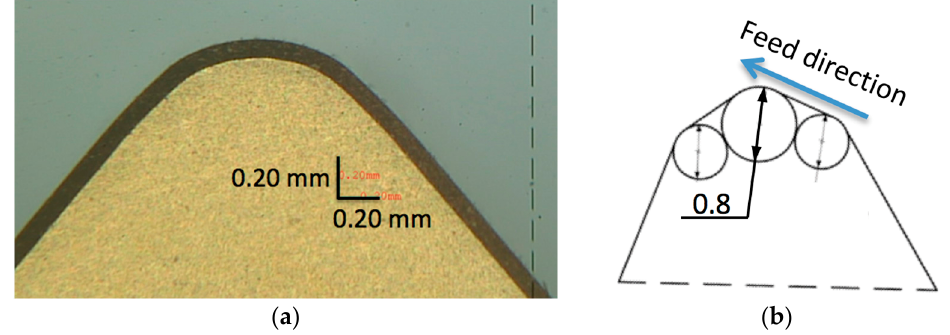
Figure 2. Insert CNGA120408T01030AWH class 7015 with WIPER geometry: ( a ) photo from microscope; ( b ) explanation of WIPER geometry. Table 1. Machining parameters used in the experiments for the respective samples. Sample Notion Cutting